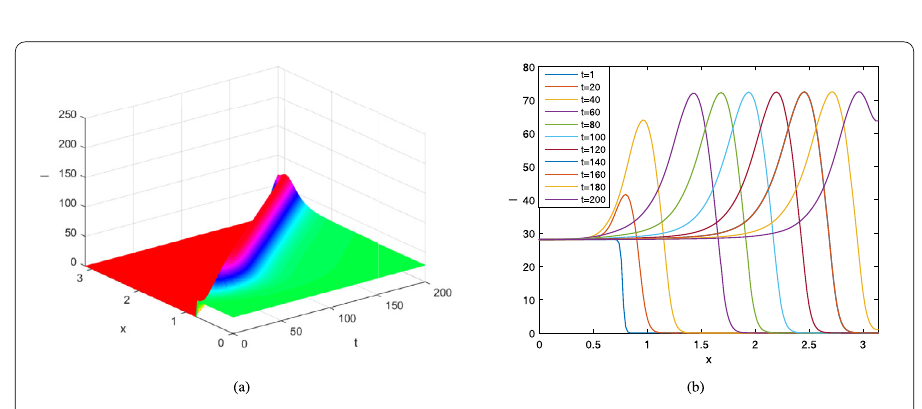
Figure 8 Traveling waves of system (2.1) in the case 1 < R c < R 0 . ( a ) Solutions I ( x , t ); ( b ) Solutions I ( x , t ) are in terms of different